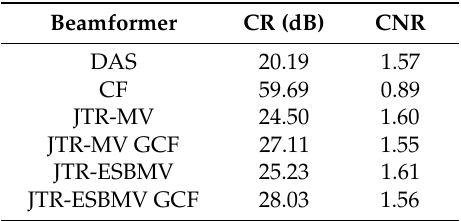
Table 6. CR and CNR for a human carotid